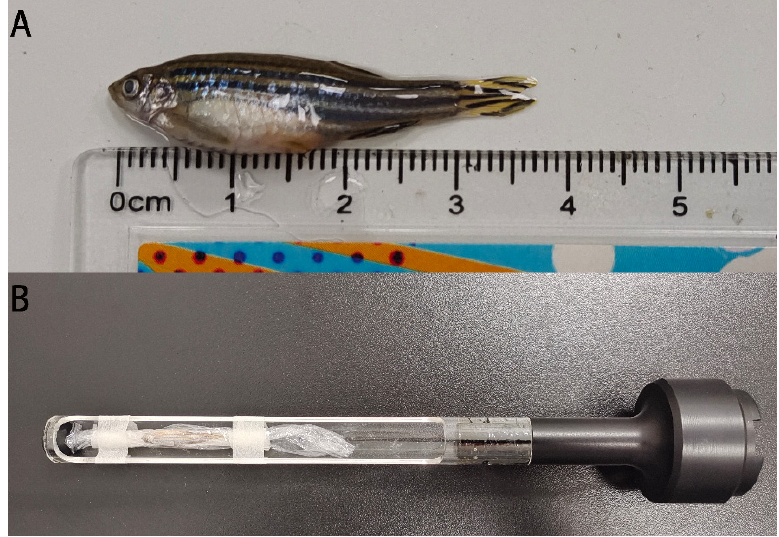
Figure 2. The zebrafish used in the experiment ( A ) and the sample table used for sample fixation ( B ).